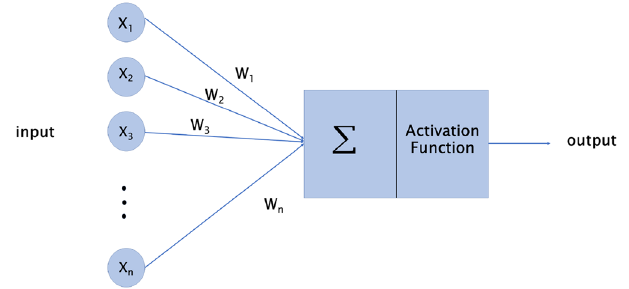
Figure 2. An overview of an artificial